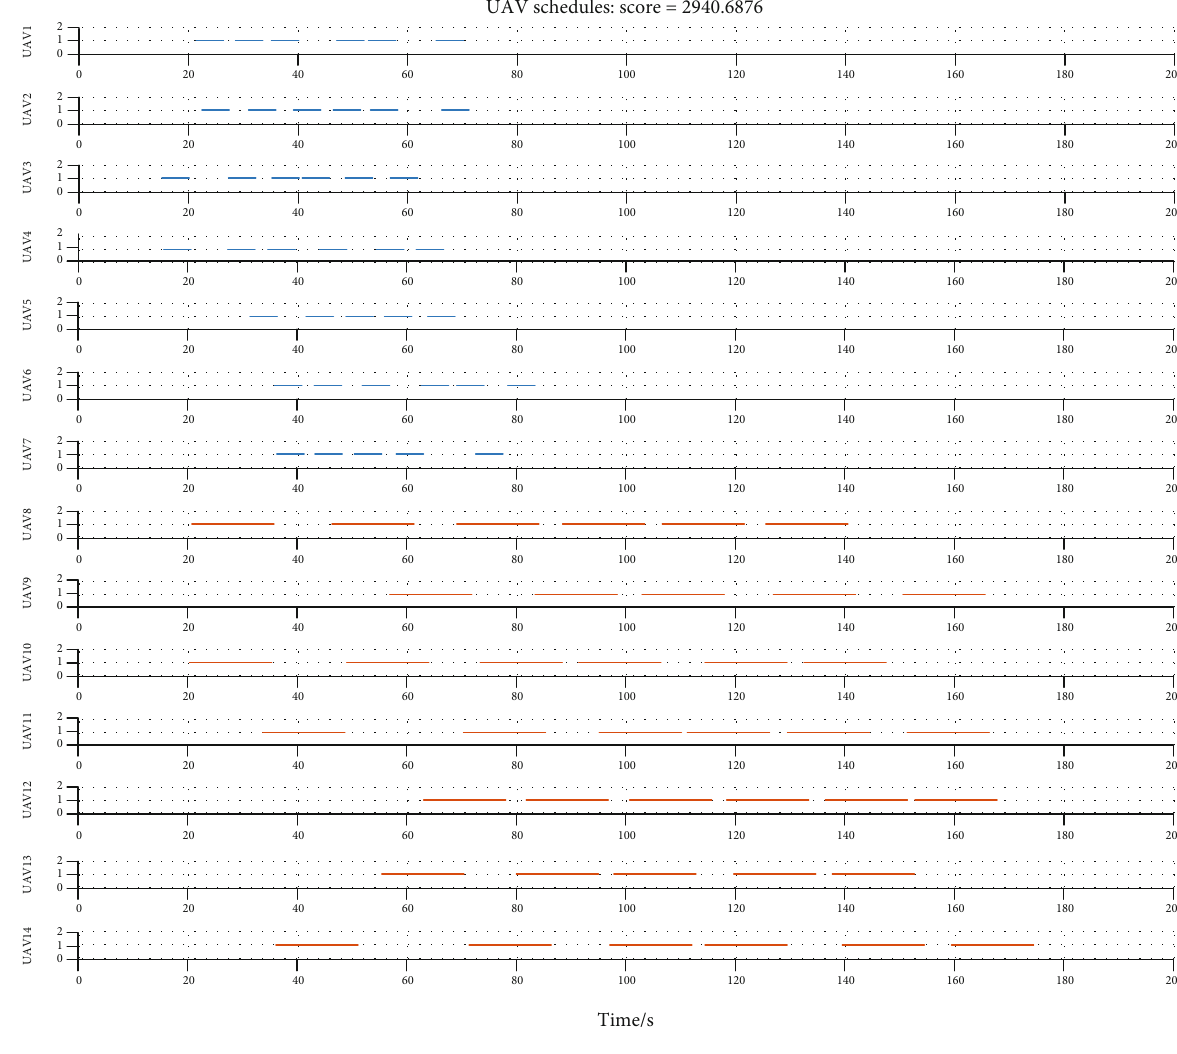
Figure 6: UAV schedules.